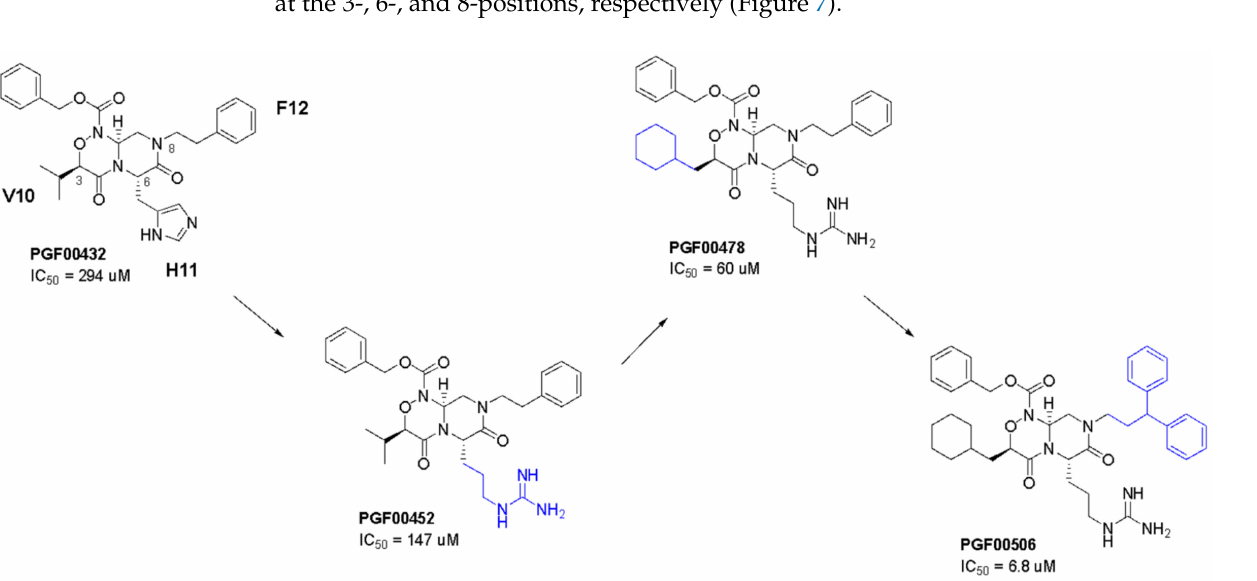
Figure 7. Chemical structures of key compounds. IC 50 values show CTLA-4/B7-1 interaction inhibitory activity. Three amino acids (V10, H11, F12) on PGF00432 correspond to C4m-3127 H10V random loop: 1 MHPFLPIVSVHF 12